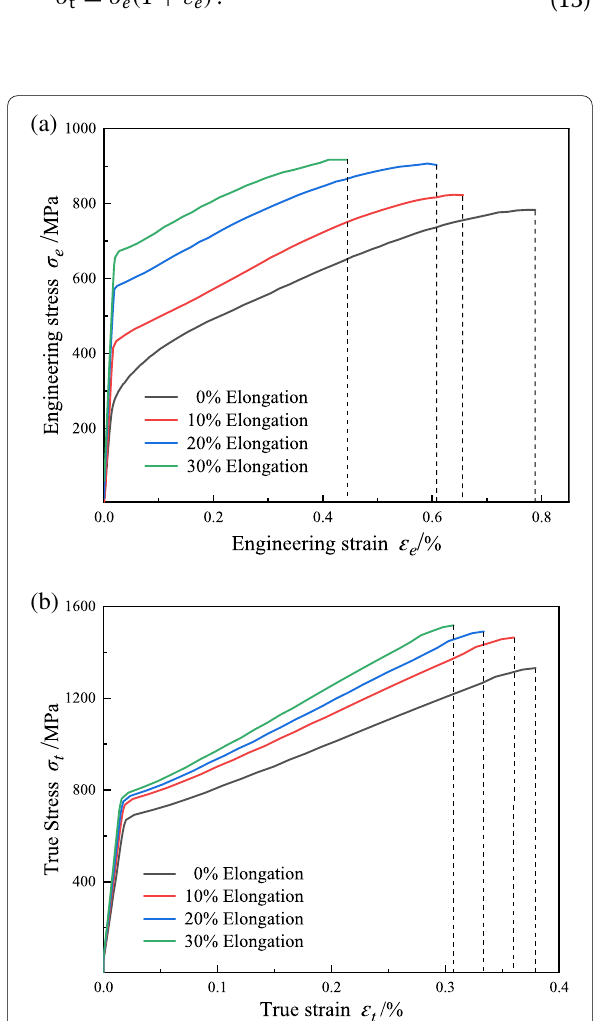
Figure 6 (a) Engineering stress-strain curves under different elongations, (b) true stress-strain curves under different elongations